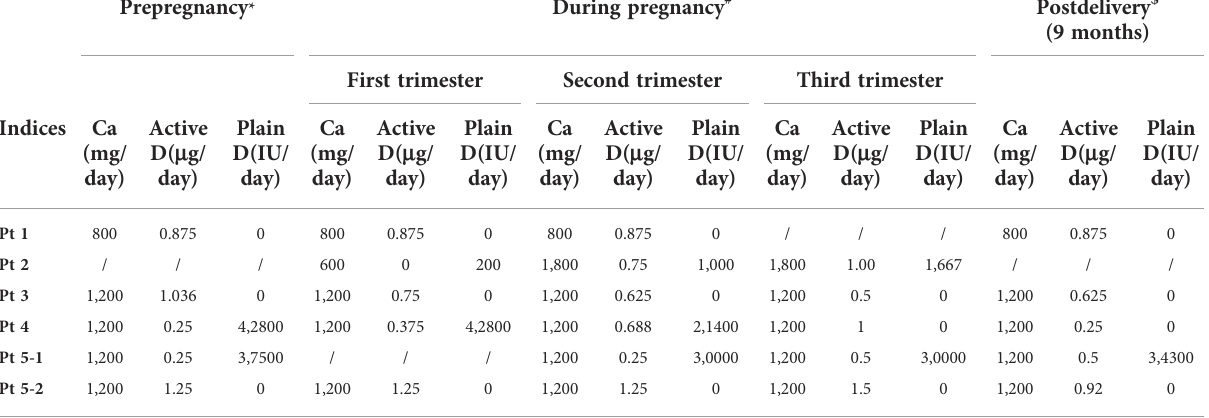
TABLE 3 Changes in medicine dosage during pregnancy and after delivery. Prepregnancy